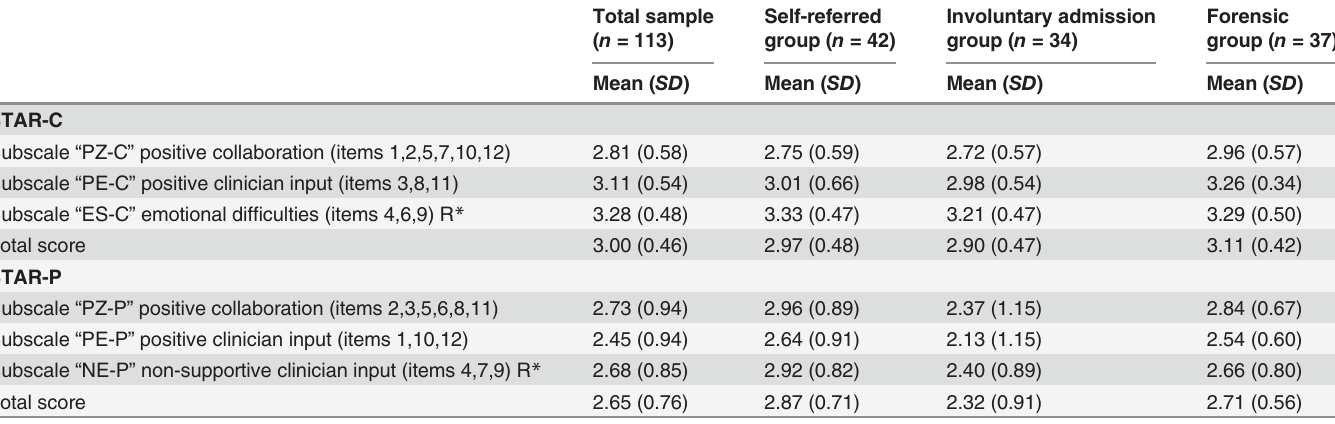
Table 2. The mean STAR total and subscale scores for groups of self-referred, involuntary admission, and forensic patients as well as for the whole